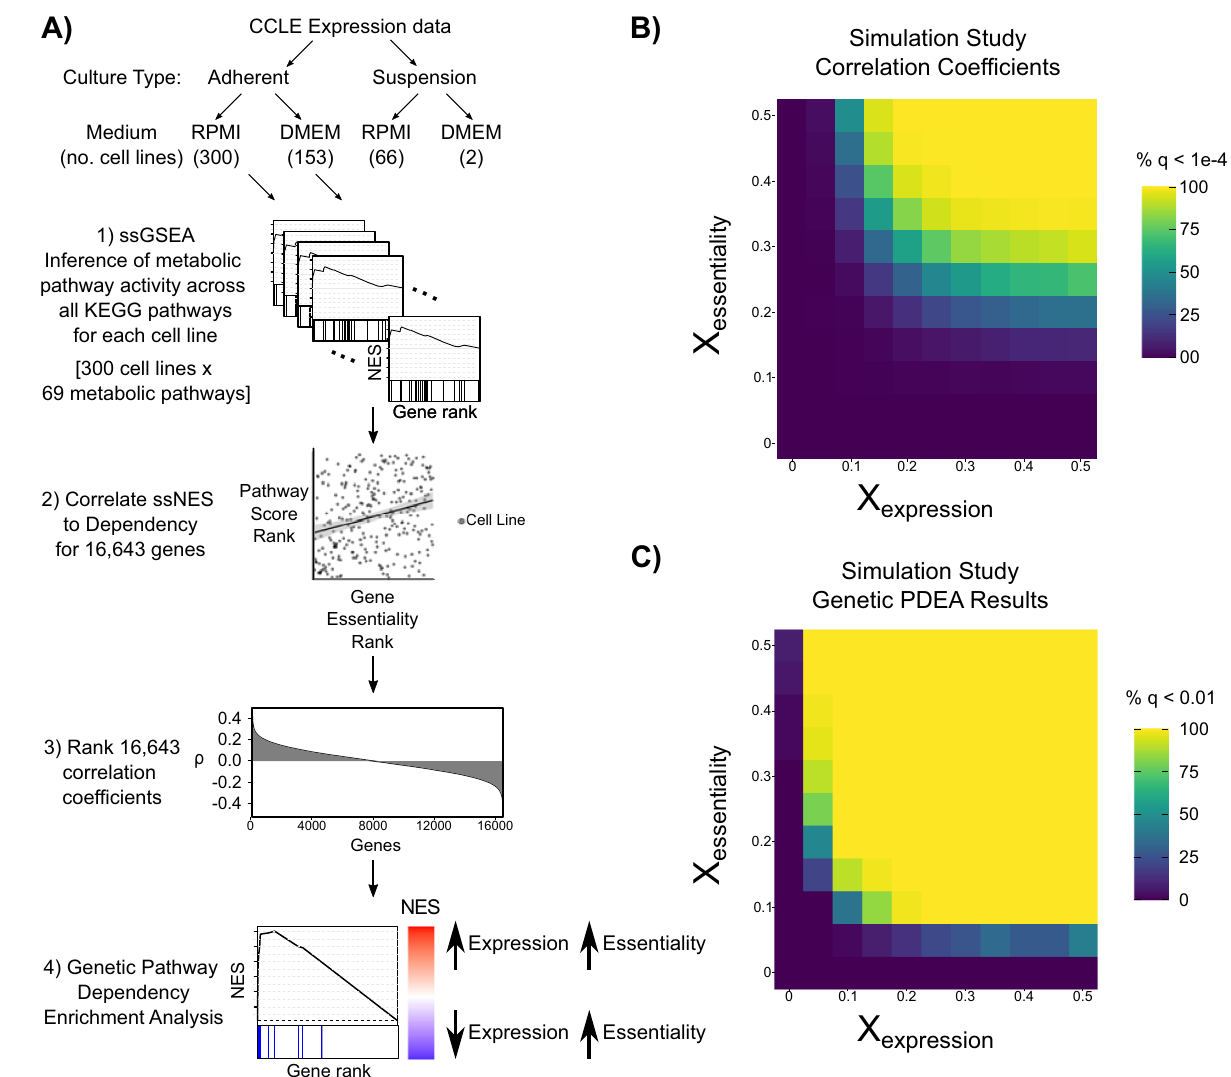
Fig 1. Integration of gene expression and CRISPR gene dependencies to identify metabolic pathway dependencies. A) Schematic outlining the approach for Genetic Pathway Dependency Enrichment Analysis (Genetic PDEA). Cancer cell lines from the CCLE were first stratified by culture type (adherent, suspension) and culture medium (RPMI, DMEM), and then their metabolic pathway activity was inferred using single-sample GSEA (ssGSEA). The resulting pathway activities were integrated with gene dependency to assess association with metabolic pathway activity. B-C) Simulated data (see Methods) was used to assess the sensitivity of the Genetic PDEA approach. The heatmaps represent the percentage of significant results at each gradient added. Values added to the expression gradient resulted in slightly stronger correlation coefficients and Genetic PDEA results compared to values added to dependency